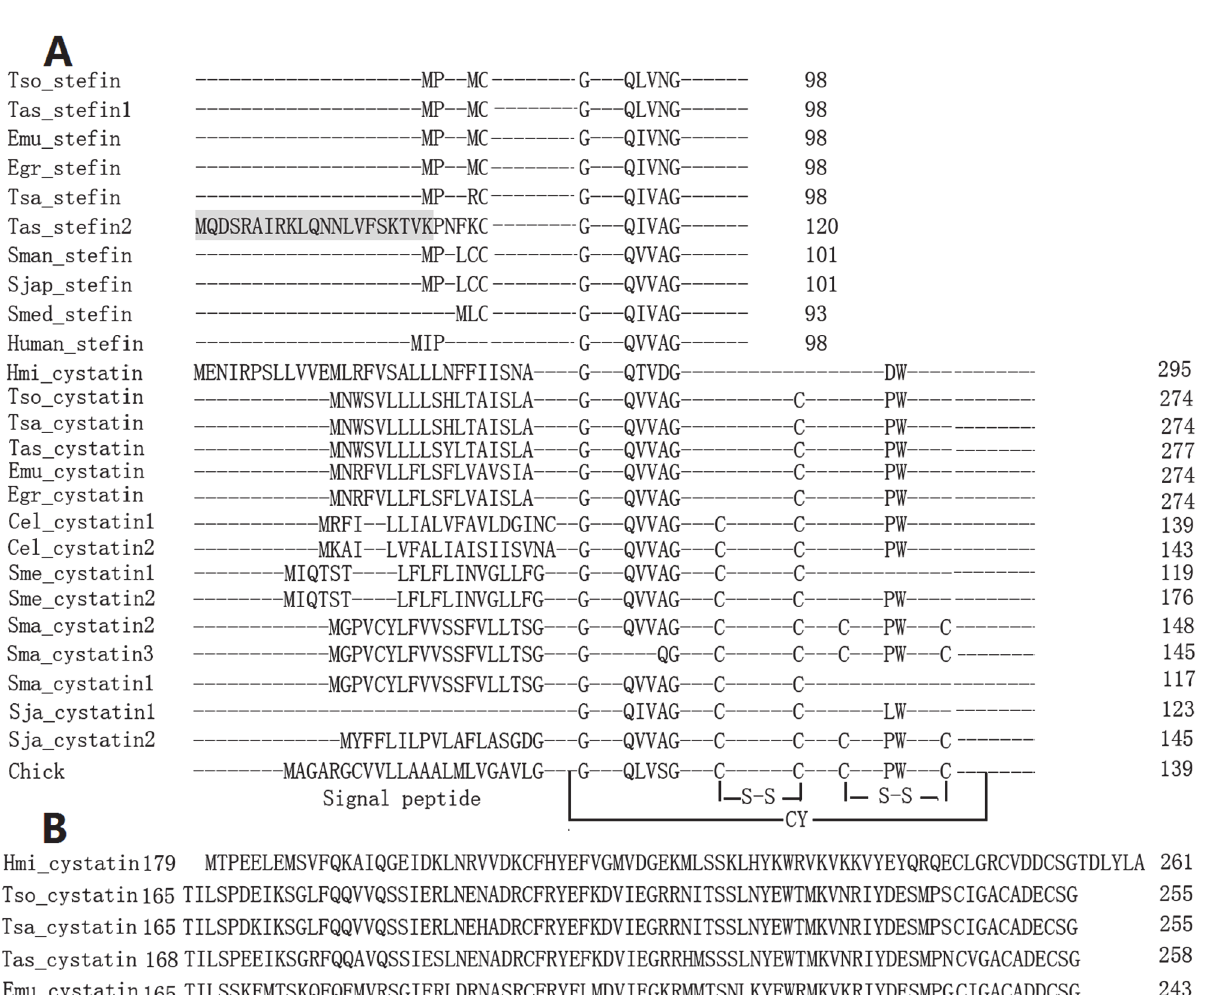
Fig 2. Alignment of cystatin superfamily domain. The domain was aligned using ClustalW and adjusted manually. (A) The three parts of the papain binding domain (G, QXVXG, PW) are displayed. Signal peptides and disulfide bridges are shown. The N-terminal amino acid extention of Tas_stefin2 is shaded pale grey. The number of amino acids of each protein is shown at last of sequence. (B) The tandem repeated domain of cestode cystatins is shown. The first amino acid and the last amino acid in the tandem repeated domain is numbered outside of